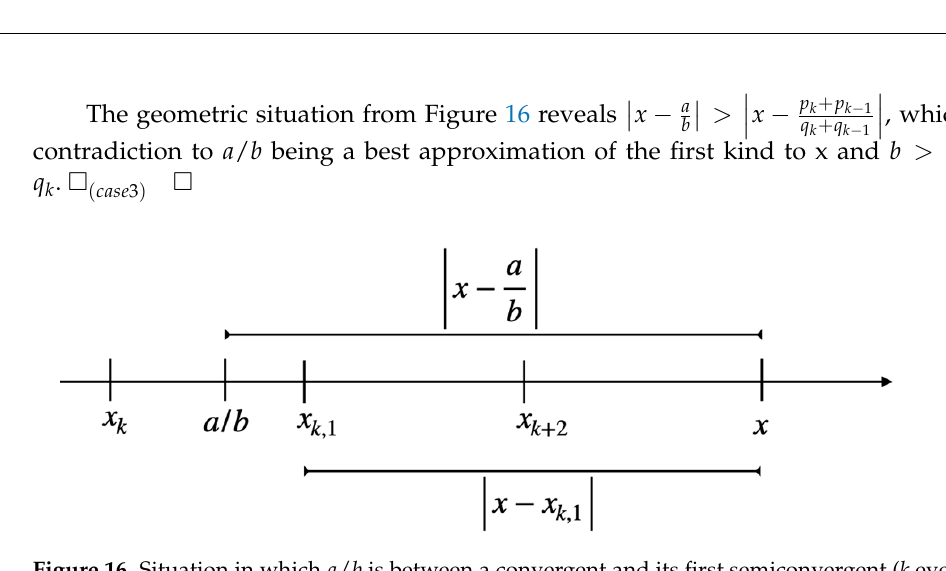
(cid:12) (cid:12) (cid:12) (cid:12) (cid:12) (cid:12) − p k + p k − 1 (cid:12) x − a (cid:12) > (cid:12) x (cid:12) , which is a q k + q k − 1 b